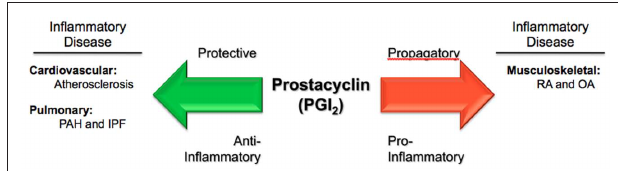
FIgure 2 | Paradoxical actions of prostacyclin in three inflammatory diseases. Prostacyclin (PGI ) serves as a protective, anti-inflammatory 2 mediator in the processes of atherosclerosis and pulmonary vascular diseases, such as pulmonary arterial hypertension (PAH) and idiopathic pulmonary fibrosis (IPF). Conversely, in rheumatological conditions, such as rheumatoid arthritis (RA) and osteoarthritis (OA), PGI acts as a propagatory, 2